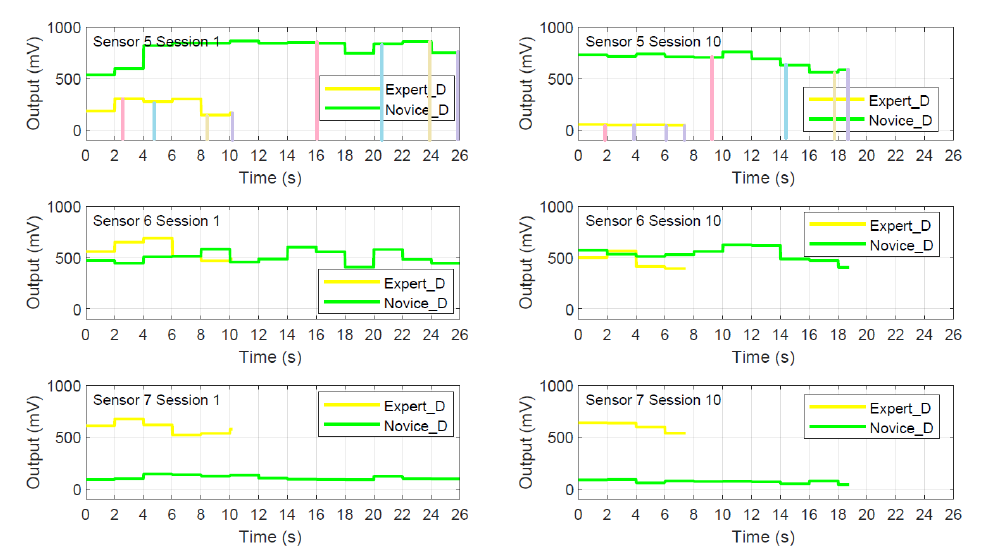
Figure 9. Average peak of three sensors on dominant hand of expert and novice for the first and last session